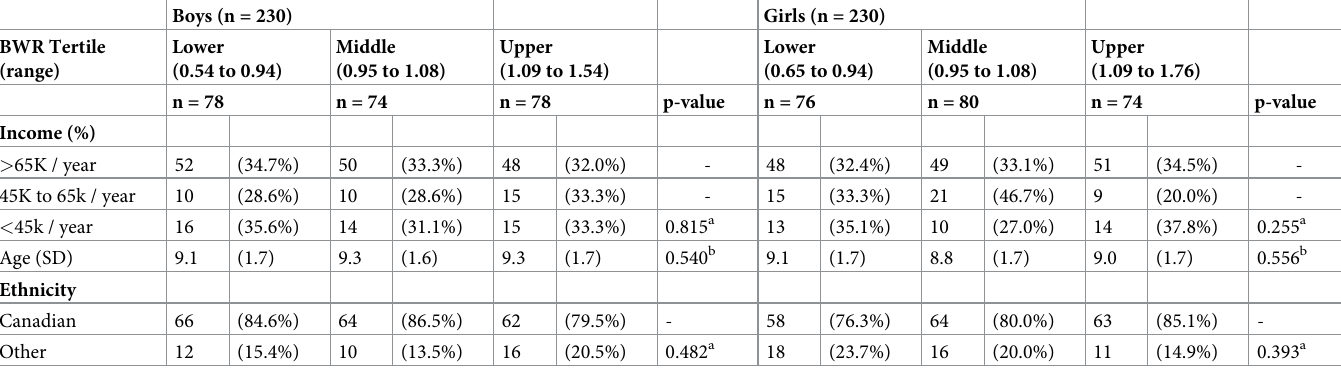
Table 2. Main effects results suggested the presence of curvilinear relationships between BWR and physical activity and screen time as indicated by significant quadratic terms. Emotional Table 1. Characteristics of the